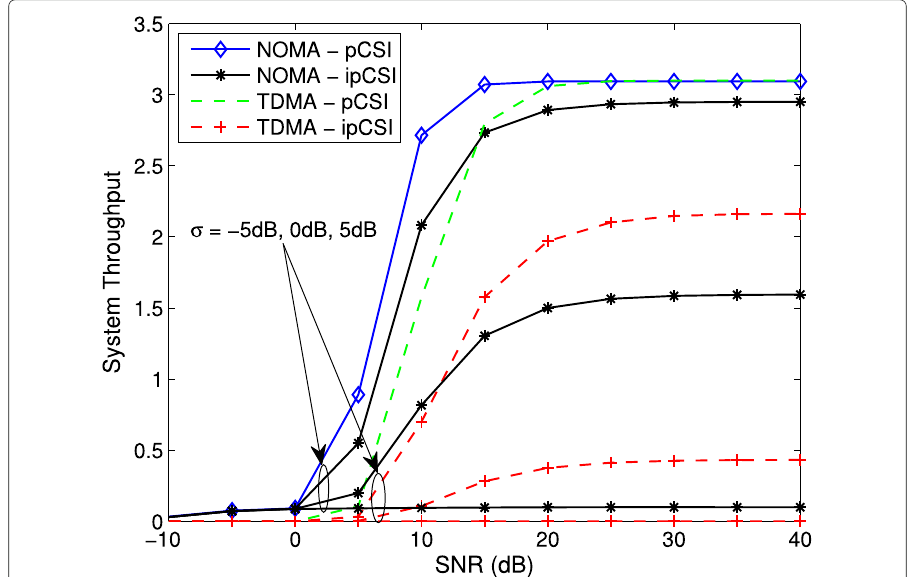
Fig. 3 System throughput versus SNR under ipCSI/pCSI conditions in delay-limited transmission